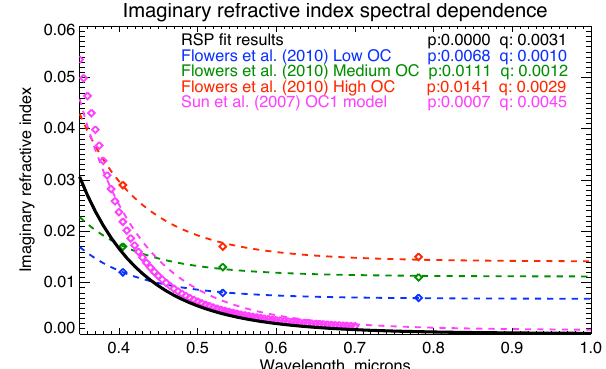
Fig. 5. Imaginary refractive index spectral dependence models from Flowers et al. (2010) (red, green and blue) and Sun et al. (2007) (magenta), compared to RSP retrieval results (black, see Sect. 4). Diamonds represent the published models, while dashed lines are the fit from equation 3 to that